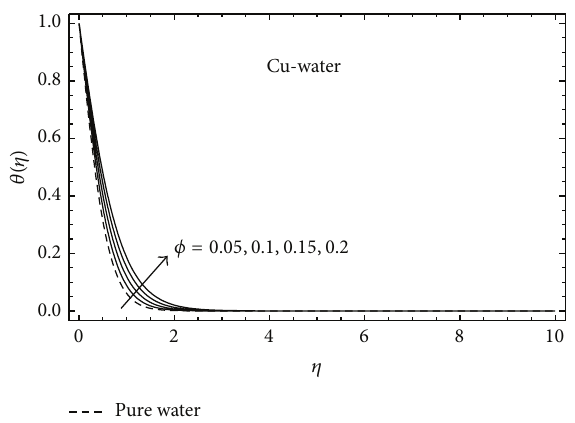
Figure 3: Effect of 𝜙 on temperature distribution 𝜃(𝜂) for Pr = 6.2 and 𝑀 = 1 .